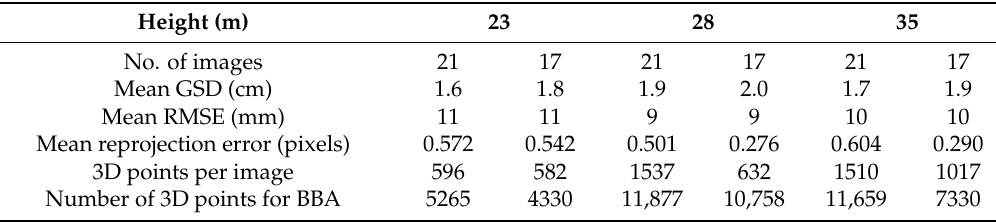
Table 5. Summary of full bundle block adjustment (BBA) quality report.